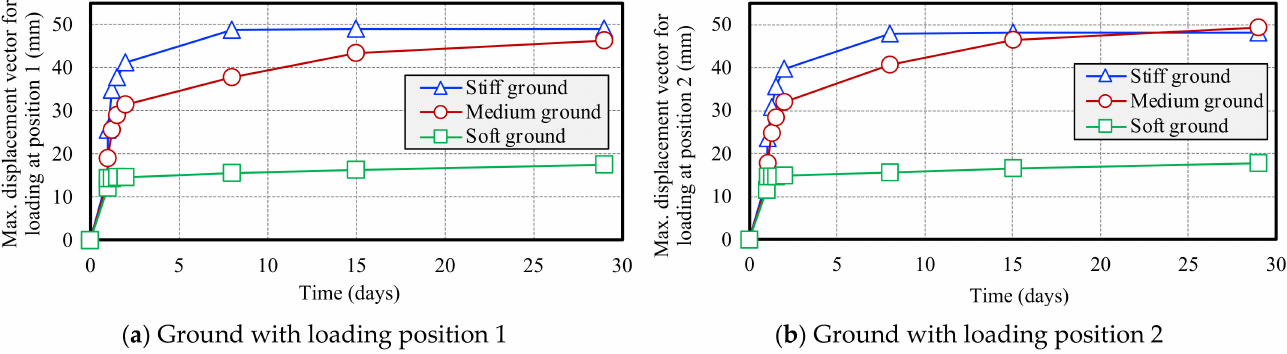
Figure 15. Rates of change in maximum displacement vectors for double boreholes under the loading